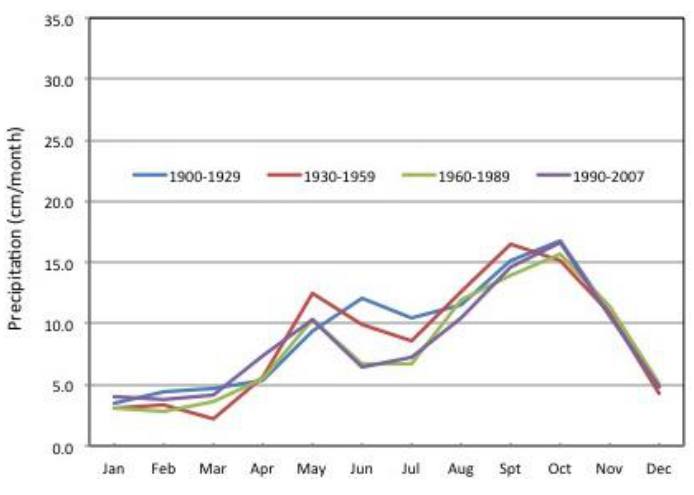
Figure 17. Dry forest annual cycle monthly precipitation by